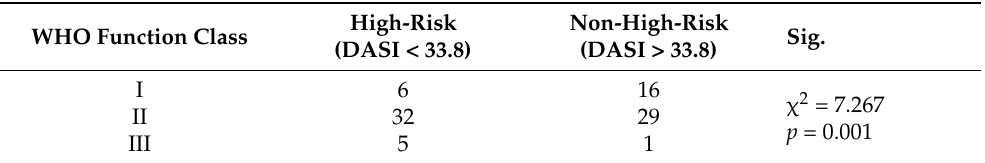
Table 3. Distribution of WHO functional classes in high-risk and non-high-risk groups according to the cut-off value of the